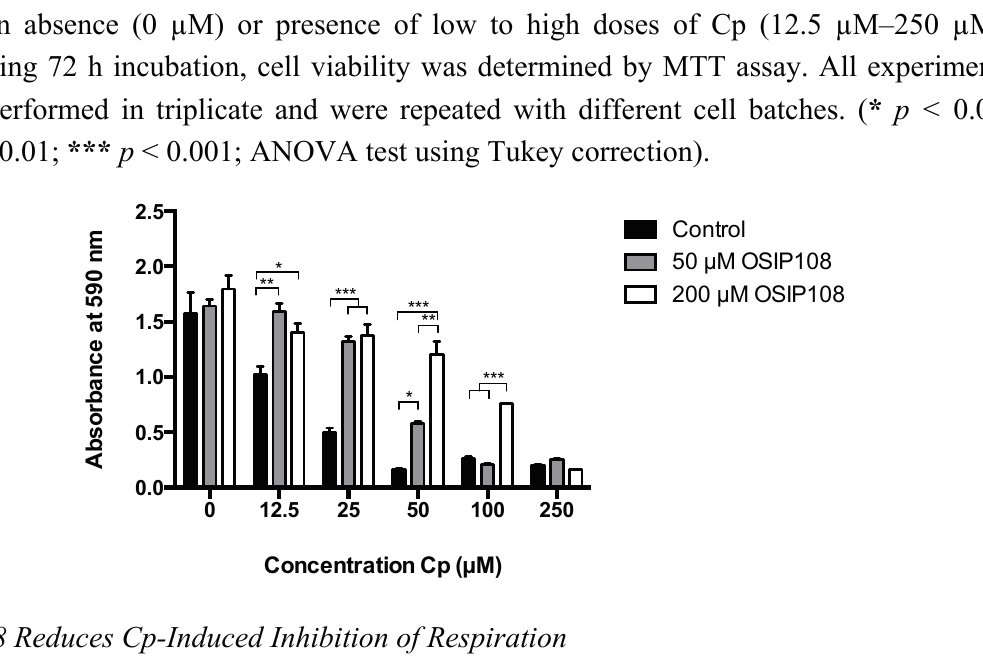
Figure 1. OSIP108 increases tolerance of HepG2 cells to Cp. HepG2 cells were incubated with control (1% DMSO, black bars) or OSIP108 (50 µM, grey bars or 200 µM, white bars) in absence (0 µM) or presence of low to high doses of Cp (12.5 µM–250